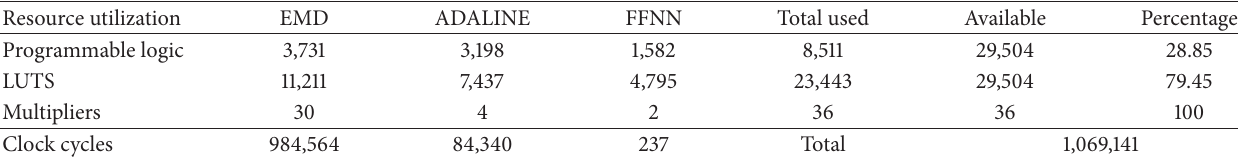
Table 4: Resource usage of the FPGA.